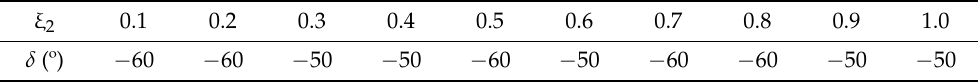
Table 3. Crack initiation angles (degree) calculated using finite element method when ϕ = 15 ◦ .